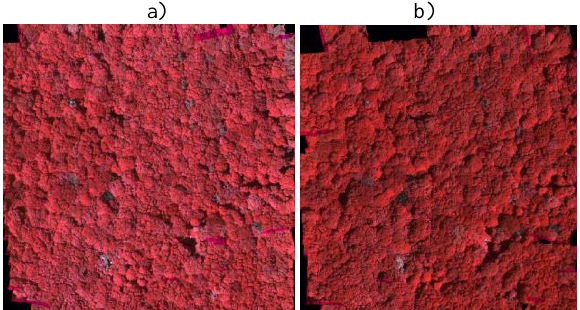
Figure 11. Hyperspectral image mosaics composed of approximately 250 images from a) morning (f1) and b) afternoon (f6) flights.